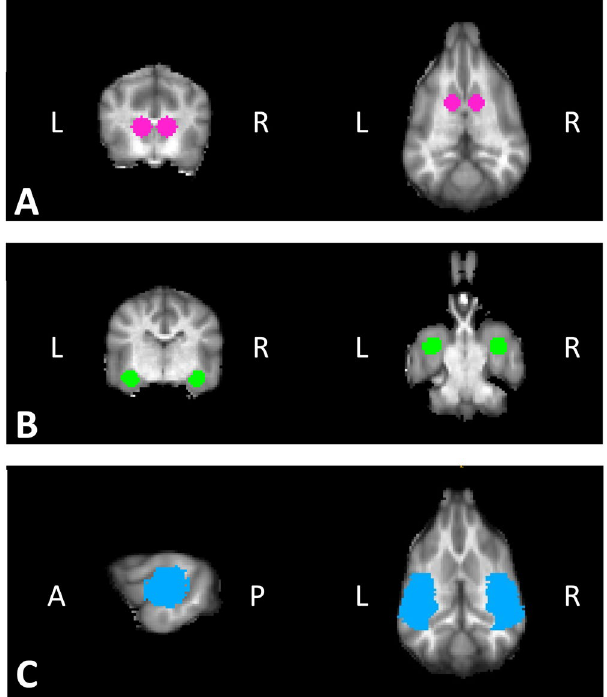
Figure 2. Regions of interest (ROIs) defined a priori. ROIs were drawn in individual anatomical space, example ROIs shown in template space here in transverse and dorsal views. ( A ) Caudate nuclei have been shown to differentially respond to stimuli associated with reward and no-reward. ( B ) Amygdalae have shown differential responding to stimuli associated with reward and no-reward, as well as arousal. ( C ) Parietotemporal regions including primary auditory cortex respond to verbal stimuli, including nonwords. ROI is shown here in sagittal and dorsal views in template space.